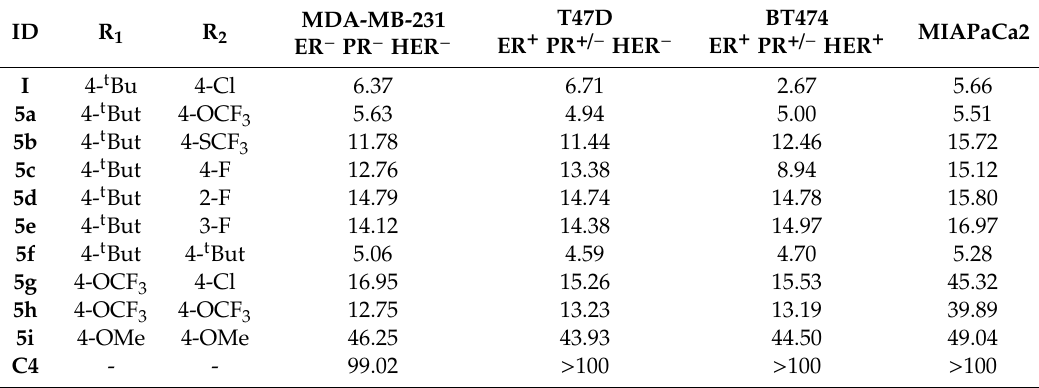
Table 1. In vitro anti-proliferative activity (IC 50 in μ M) of compounds ( I , 5a – i ) compared to chloropyramine ( C4 ) in human breast (MDA-MB-231, T47D, and BT474) and pancreatic (MIAPaCa2) cancer cell lines. IC 50 values represent the mean of independent triplicate experiments.